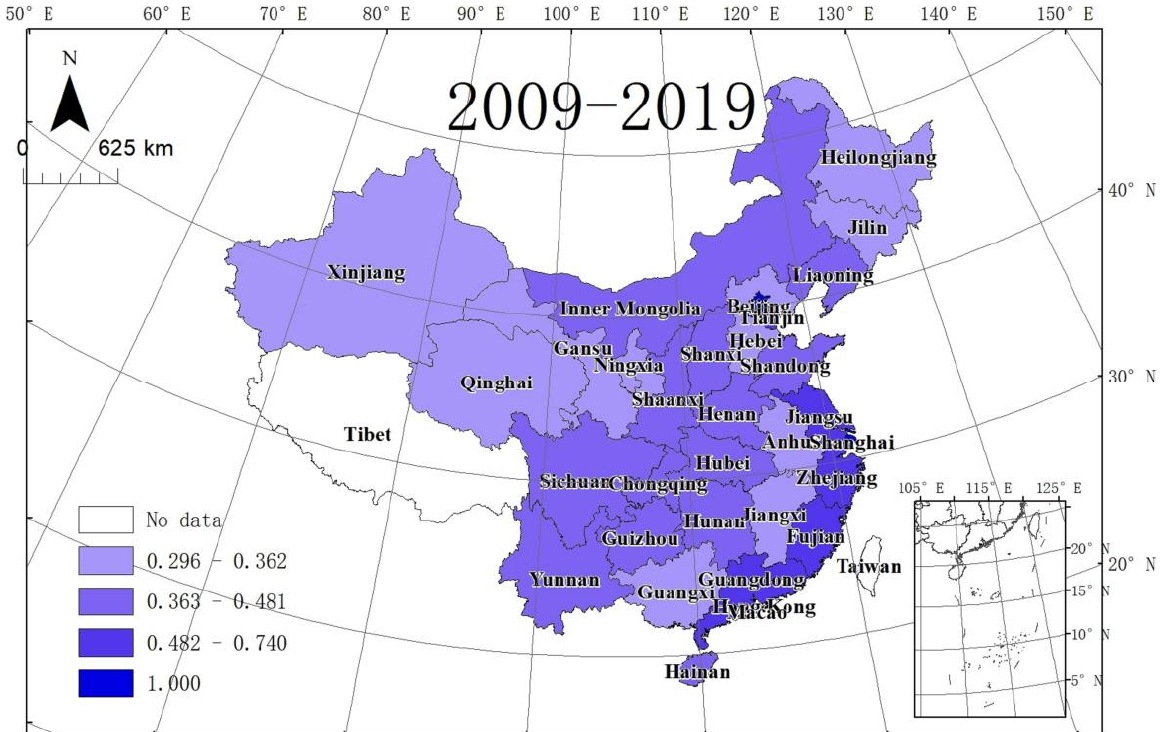
Figure 2. The annual average WRGUE of each province during 2009–2019.